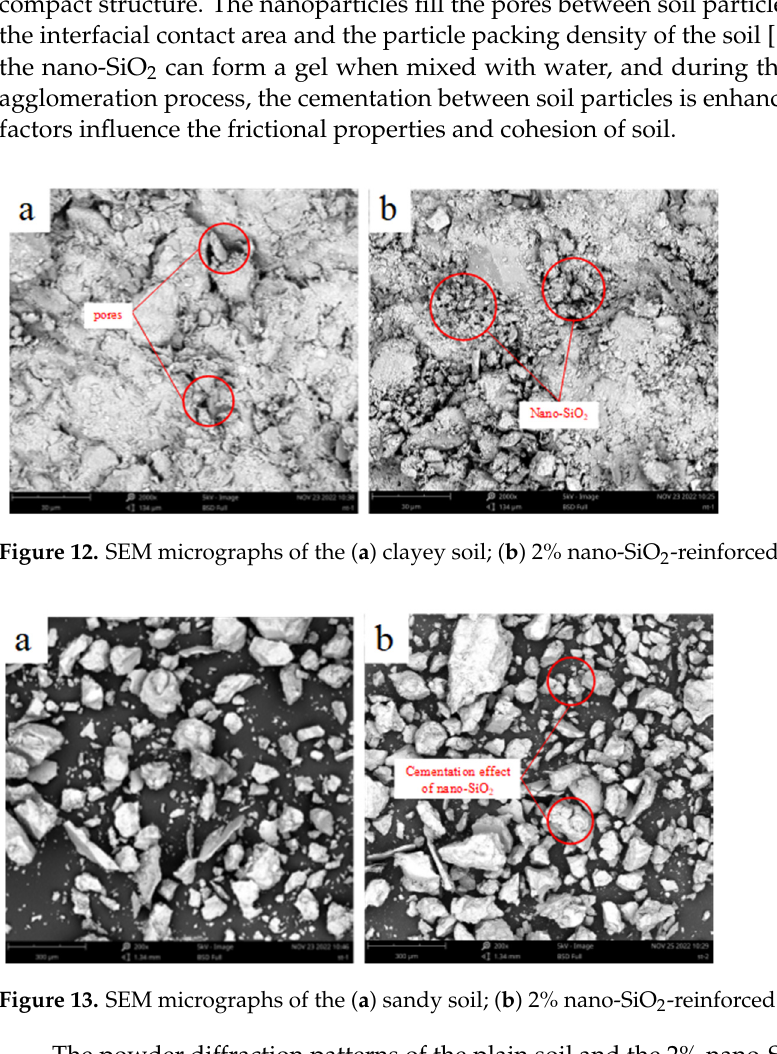
Figure 11. The ( a ) brittleness index and ( b ) displacement in peak shearing strength of the nano-SiO 2 - reinforced clayey soil ( Values are means ± S.E.M.).